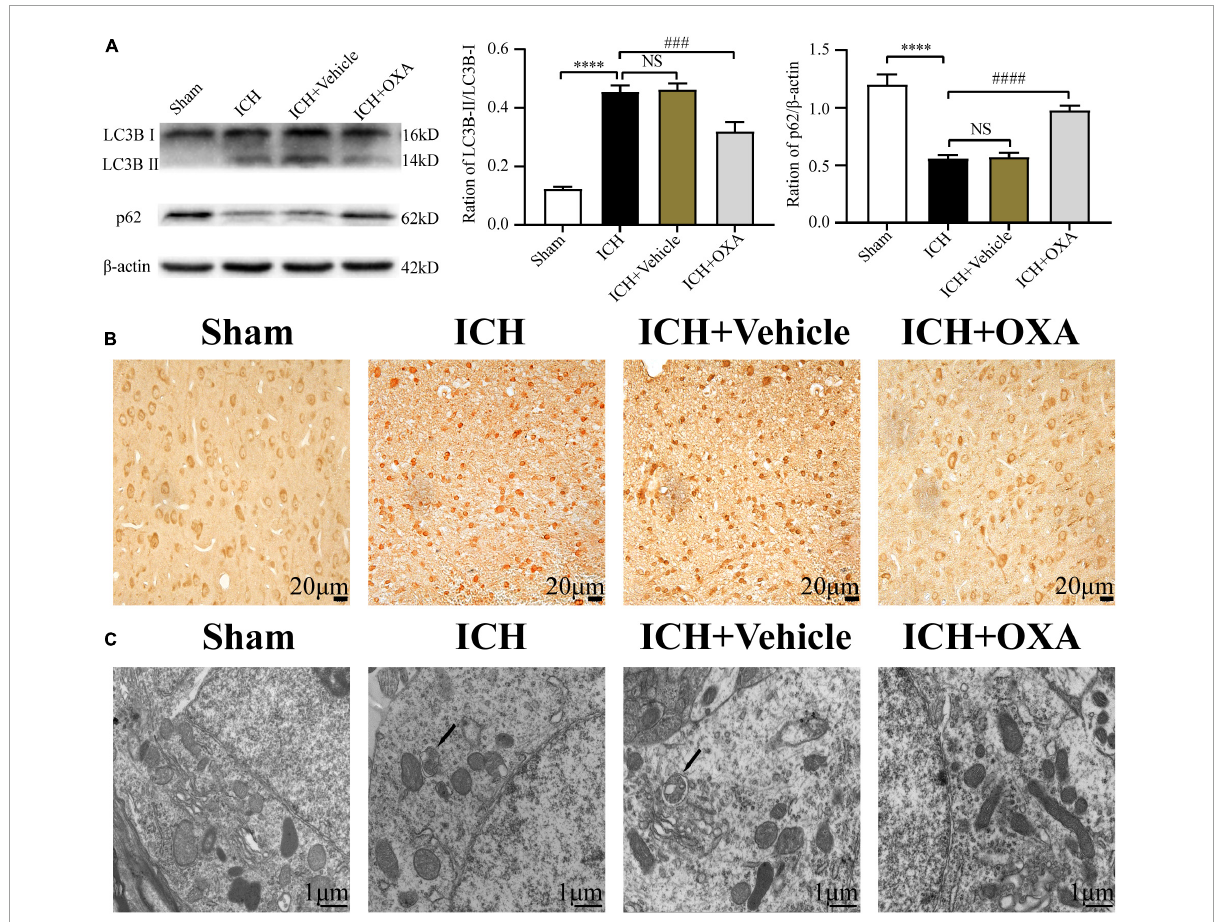
FIGURE3 Orexin-A inhibits ICH-induced autophagy activation. (A) Western blot images of LC3B and p62 and results of quantitative analysis in the perihematomal area of rats after ICH. (B) Representative immunohistochemical staining images of LC3B in each group. Positive cells were stained brown. Scale bar, 20 µ m. (C) Ultrastructural observation of perihematomal brain tissue after ICH by transmission electron microscopy, black arrows represent autophagosome. Scale bar, 1 µ m. ∗∗∗∗ p < 0.0001 vs. the sham group; NS, non-significant different compared to the sham group; ### p < 0.001, #### p < 0.0001 vs. the ICH